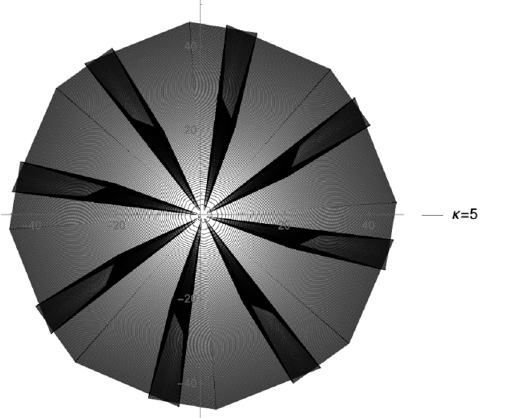
Figure 4 . Plot of Z Right: m = 0 : 1 + i